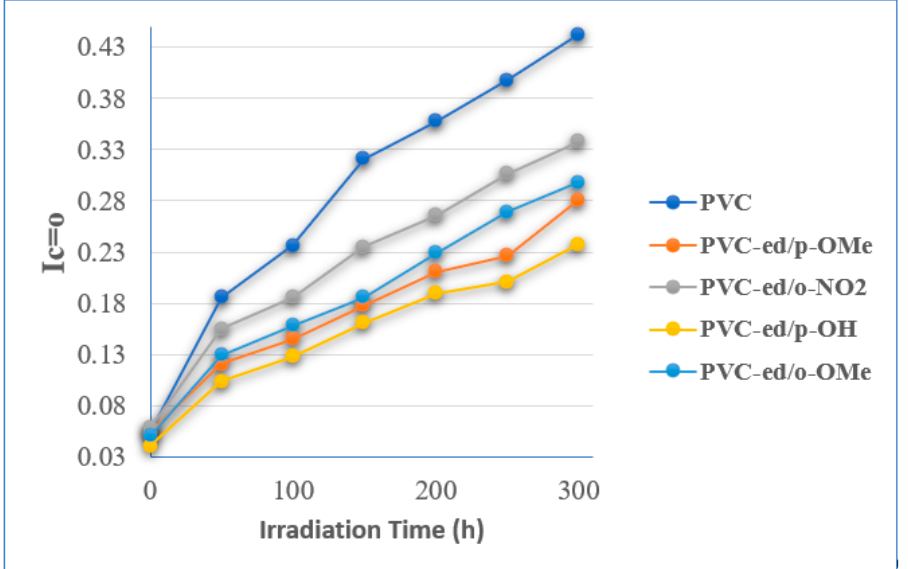
Figure 7. Carbonyl group index against irradiation time for prepared polymeric films .